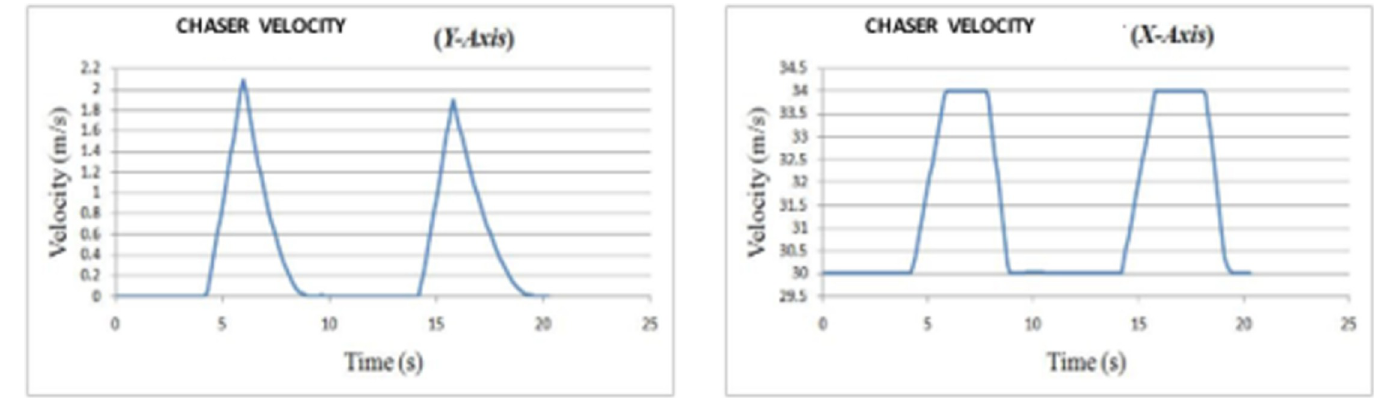
Fig 9. Lateral and axial velocities of C in scenario 1.